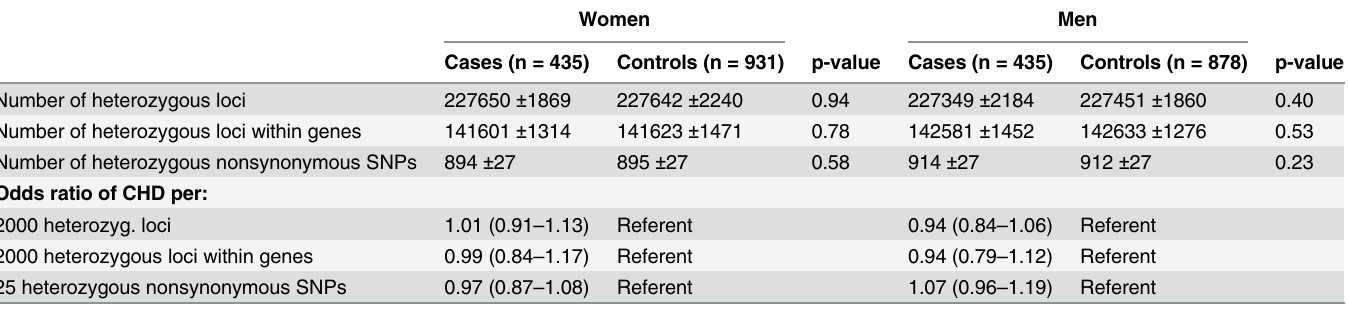
Table 1. Mean ( ± SD) numbers of heterozygous loci among CHD cases and controls and odds ratios (95% confidence interval) for CHD associated with heterozygous loci.